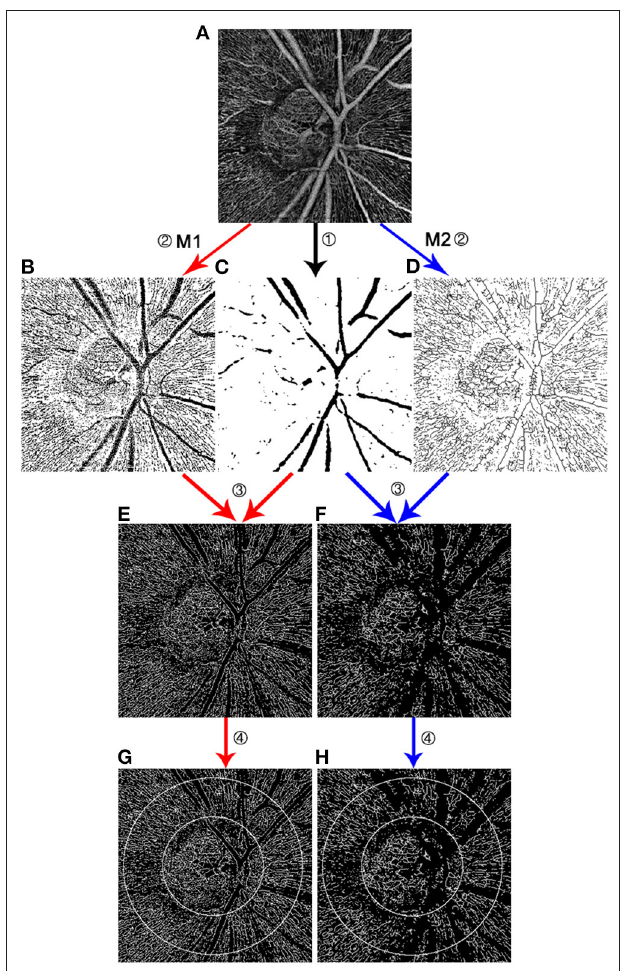
FIGURE 1 | Comparison of two methods measuring radial peripapillary capillary vessel density. Both M1 and M2 required to process on original images output by OCTA (A) . ‹ Through Image J, the extraction of major vessels was obtained using threshold tool (C) . › M1 binarized images after sharpening (B) , while M2 binarized and skeletonized the images at this process (D) . fi Using the same MATLAB code, the skeletonized images with the removal of big vessels were obtained. Image (E) was the result of image (B) minus image (C) . Image (F) was the result of image (D) minus image (C) . Outlines of the big vessels were better eliminated in the image (F) by M2 than in the image (E) by M1. fl A 750 µ m annulus was established extending from the disc margin (G,H) .